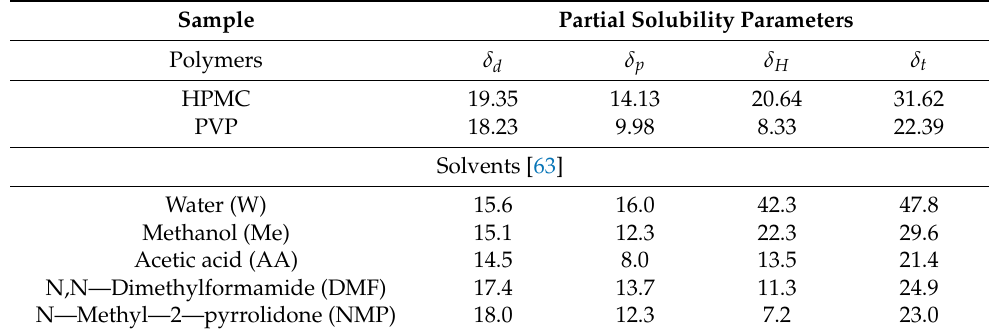
Table 5. Hansen solubility parameters of HPMC, PVP, and different solvents from literature (MPa) 1/2 .